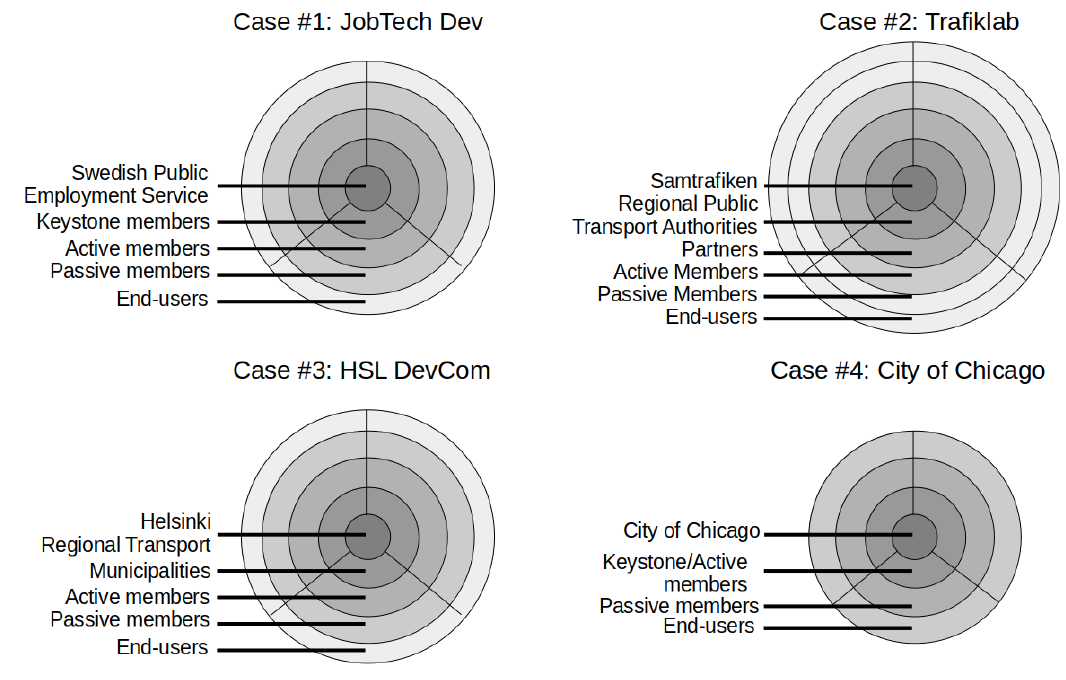
Figure 1: Overview of the governance structure of the four cases in this study, JobTech Dev (upper left), Trafiklab (upper right), HSL DevCom (lower left), and City of Chicago (lower right), based on the govern- ance model presented in earlier work (Linåker and Runeson 2020a) (in turn adopted from Nakakoji et al. (Nakakoji et al. 2002)). The core is occupied by the platform provider who controls development and data shared on platform. Ecosystem actors are divided among a number of layers specific for each ecosystem. Ac- tors important to the platform provider and ecosystem, and with high influence on the platform are close to the core. Influence and activity decrease for each additional layer. The closer to the core, the more influence they have on the